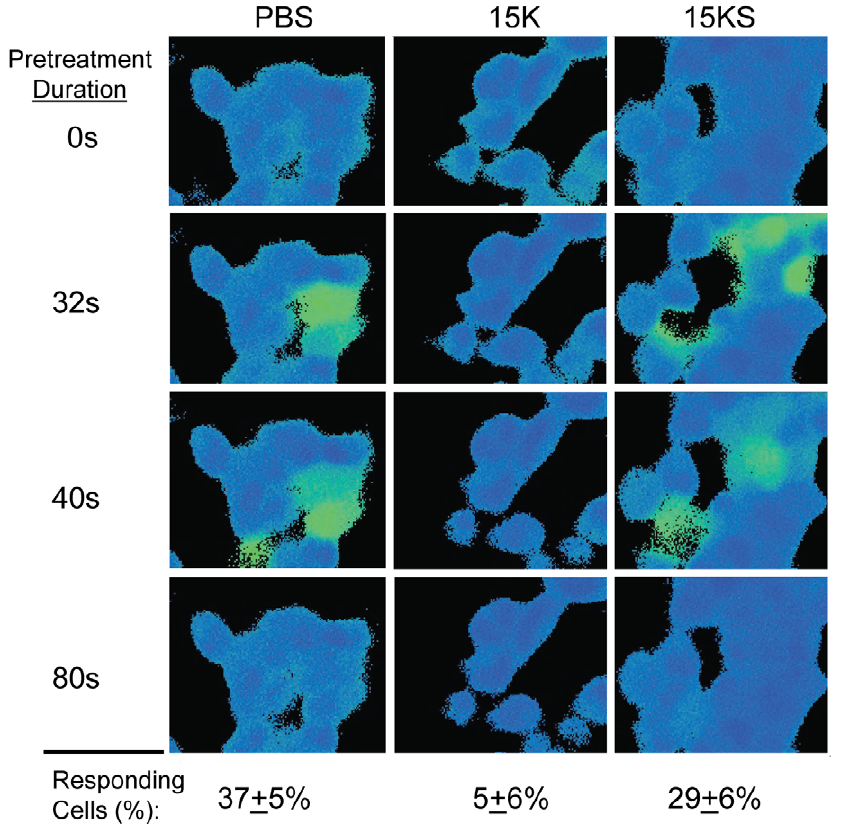
Figure 4. Effect of peptides 15K and 15KS pre-treatment on the mobilization of intracellular Ca 2 + in CXCR4/HEK cells in response to CXCL12. Cells loaded with Fura-2 were preincubated with peptides at a final concentration of 1.8 mM for 12 sec prior to stimulation with CXCL12 (15 nM).